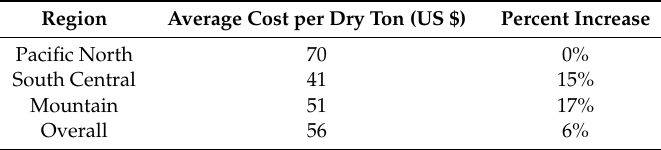
Figure 2. Anaerobic digestion reaction processes.